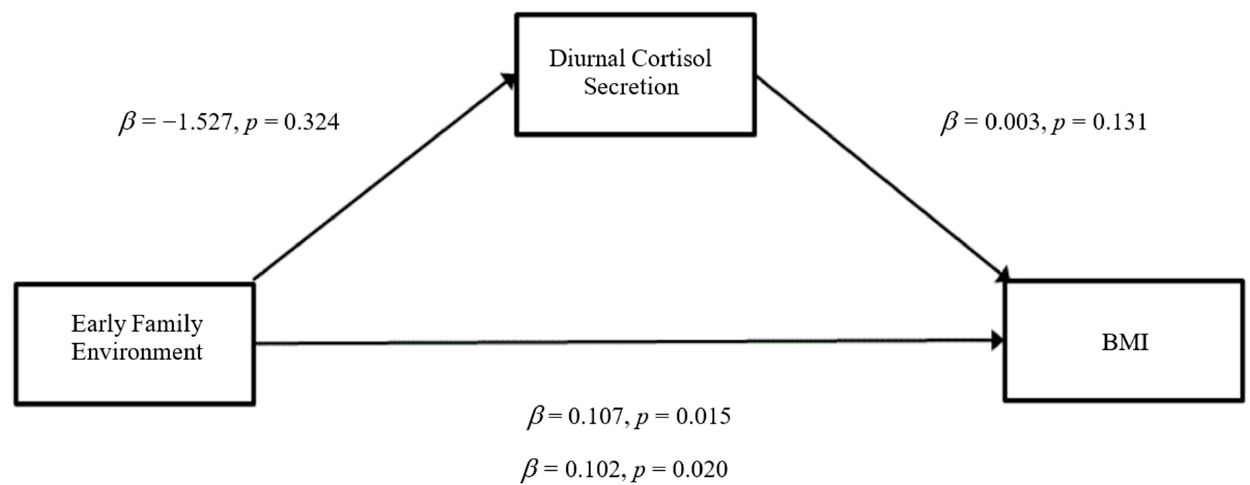
Figure 1. Mediation model for early risky family environment effect on BMI through the pathway of diurnal cortisol secretion (Model 4).